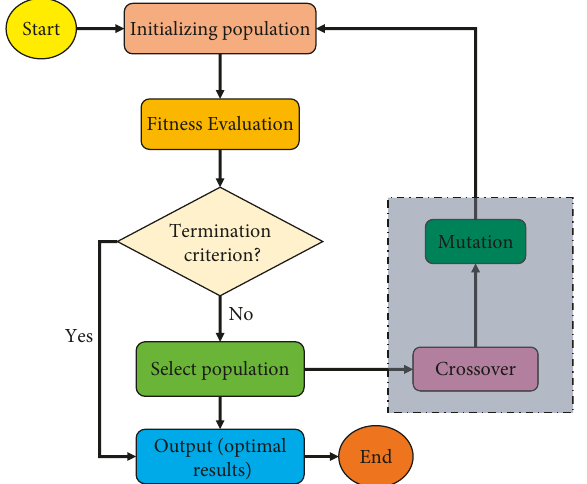
Figure 5: The basic structure of